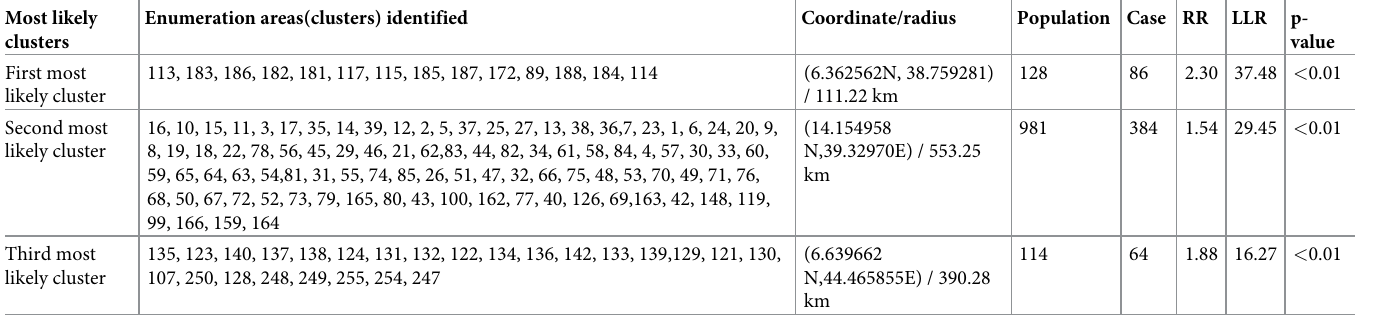
Table 2. Most likely clusters of spatial scan statistics analysis of home delivery after ANC visit in Ethiopia, MEDHS 2019. Most likely Enumeration areas(clusters) clusters